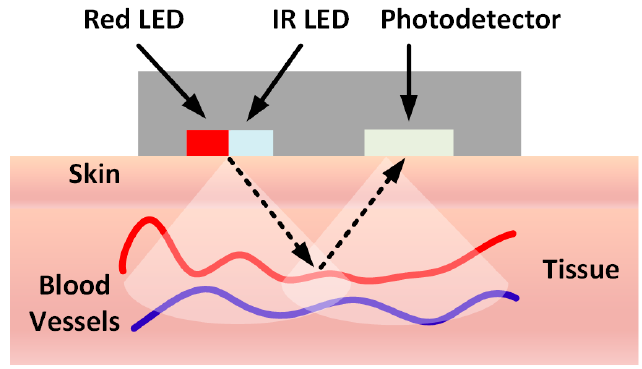
Figure 5. Working principle of SpO2 Sensor.